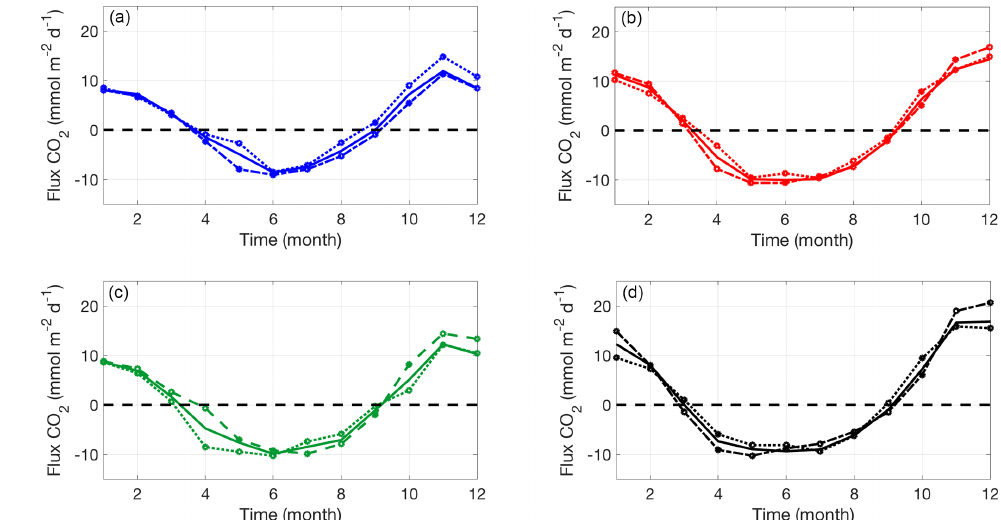
Figure 5. Seasonal cycle of air–sea CO 2 flux for the (a) Gulf of Bothnia, (b) Central Basin, (c) Gulf of Finland, and (d) South Basin. Solid lines represent the average for the full period (1998 to 2011), dotted lines with markers are for the first 5 years (1998–2002), and dashed lines are for the last 5 years (2007 to 2011). In the legend: GB: Gulf of Bothnia; CB: Central Basin; GF: Gulf of Finland; SB: South Basin; and BS: Baltic Sea.